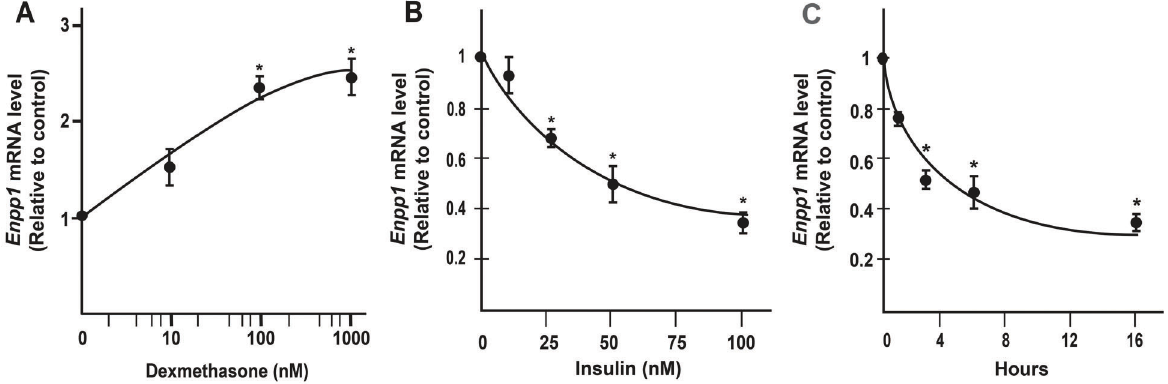
Figure 4. Expression levels of Enpp1 mRNA in HepG2 cells. A , Enpp1 mRNA in HepG2 cells treated with 10, 100, or 1000 nM dexamethasone for 16 h. B , Enpp1 mRNA levels in HepG2 cells treated with 5, 25, 75, or 100 nM insulin overnight. C , Enpp1 mRNA levels in HepG2 cells treated with 100 nM insulin for 4, 8, 12, and 16 h. Total RNA was isolated and subjected to real-time PCR analysis (n=3 independent treatments). Data are reported as means ± SE. *P o 0.05, compared to untreated controls for A and B or time 0 for C (Student ’ s t- test).